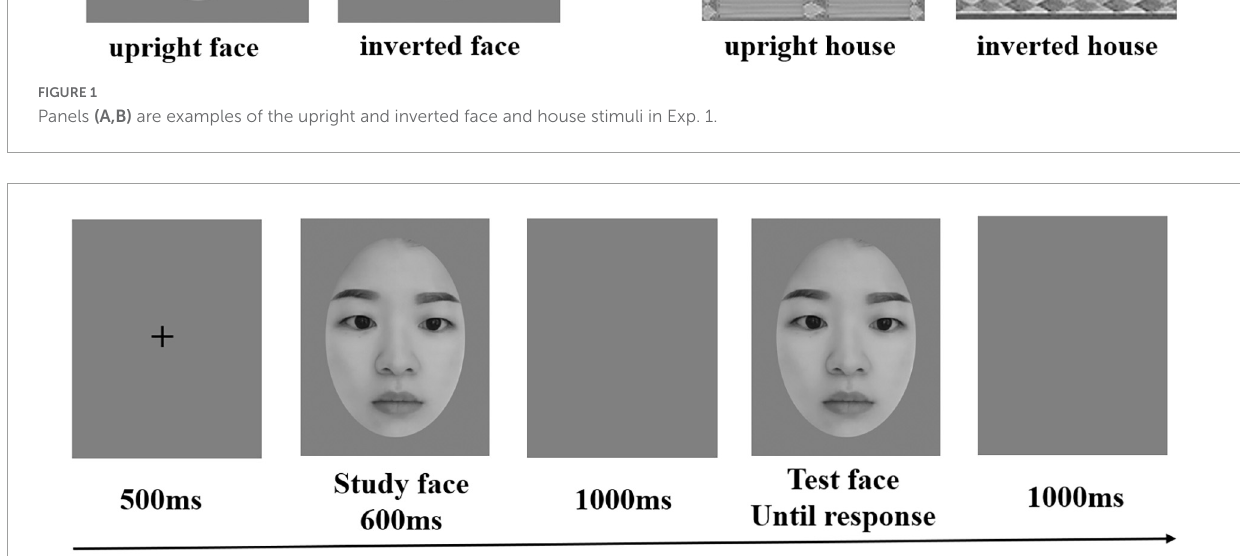
(Stimulus Category: face vs. house) × 2 (Orientation: upright